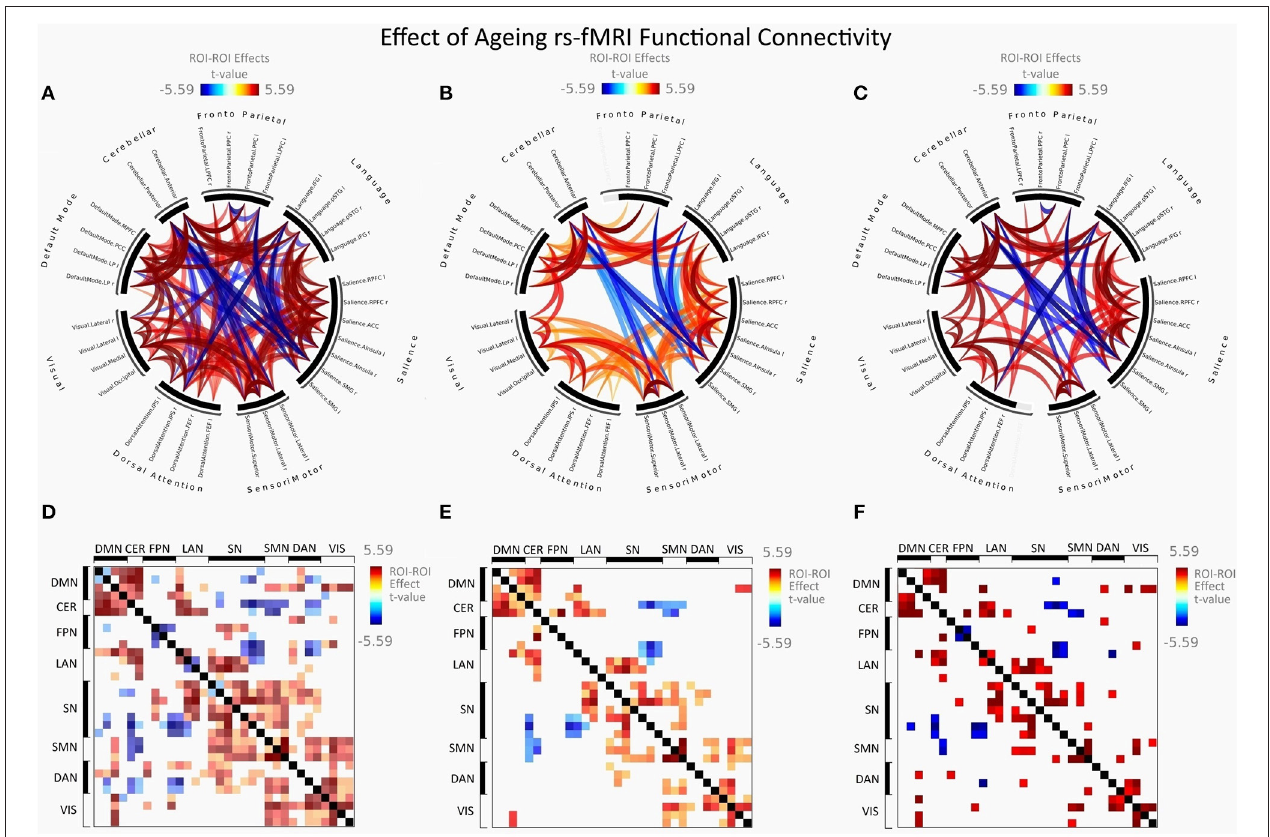
FIGURE 4 | Group differences between young adults and older adults in FC presented as a connectome ring and connectivity a matrix showing nodes with increased FC (red) and decreased FC (blue). Connectome ring representation of: (A) Functional network connectivity (FNC). (B) Spatial pairwise clustering (SPC). (C)